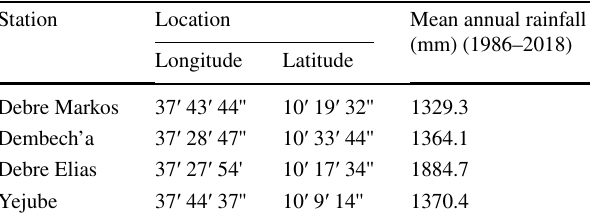
Table 3 Mean annual rainfall data for surrounding stations Station